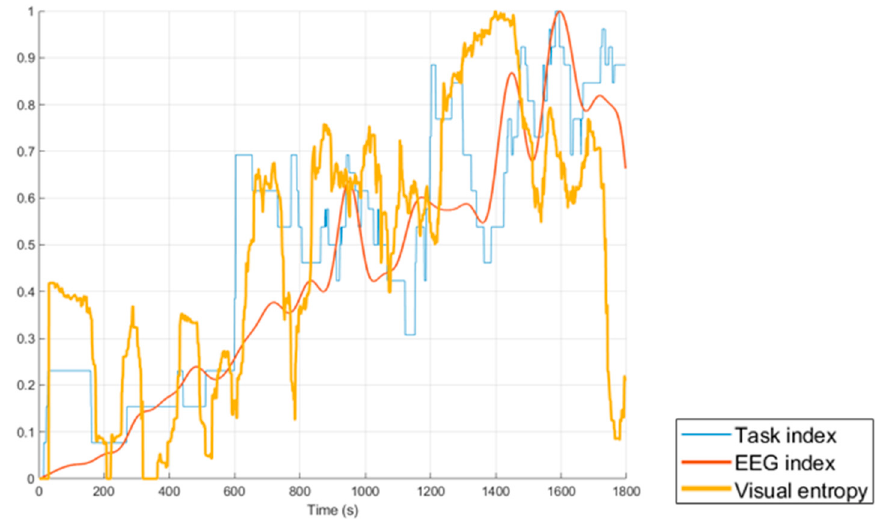
Figure 8. Comparison for one participant between the task index (blue) and the two physiological measures visual entropy (yellow) and EEG index (red).